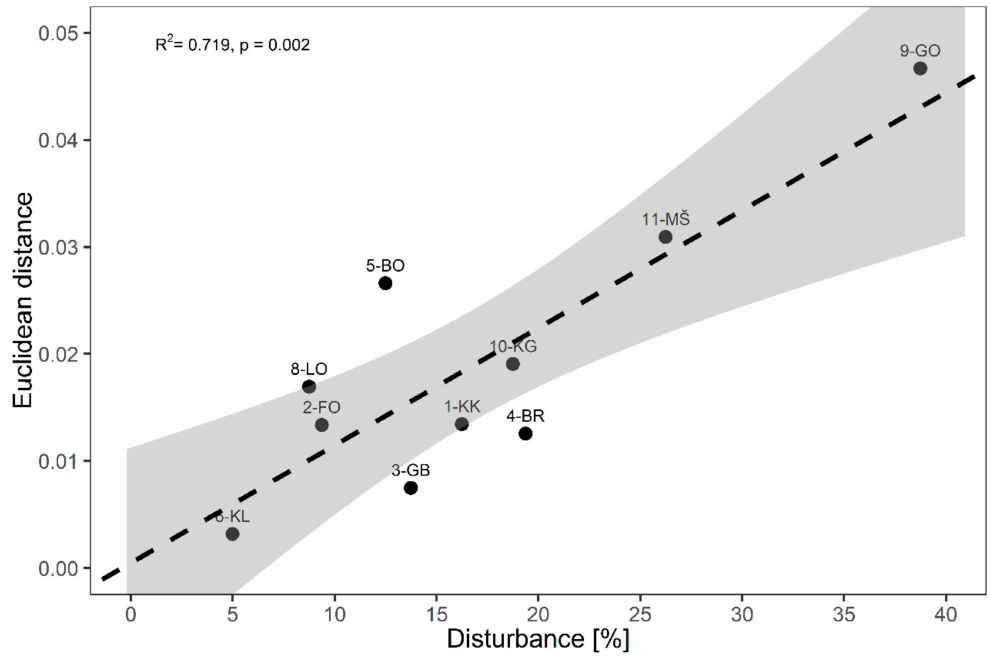
Figure 4. Linear relationship between site-level disturbance (%), estimated in P2, and the degree of compositional changes in forest vegetation, which was measured as Euclidean distance in PCoA ordination space. The grey band around the regression line denotes a 95% confidence interval. IM site labels correspond to Table